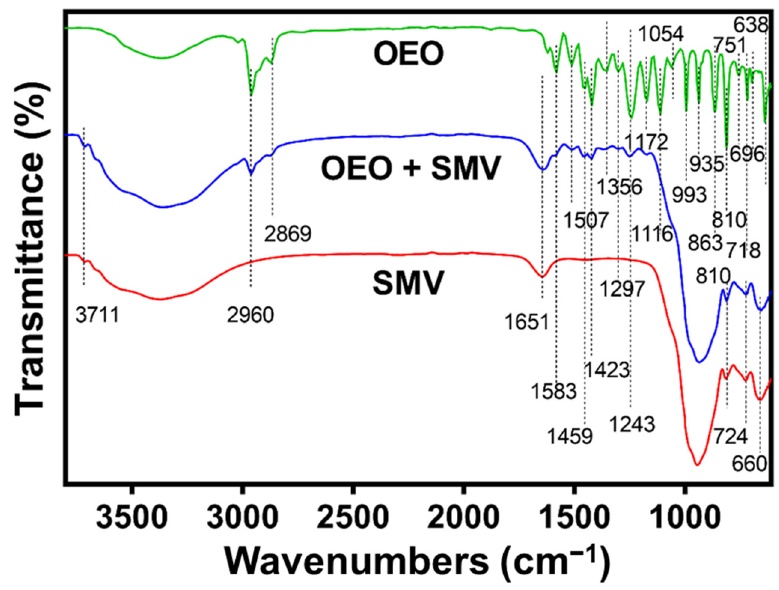
Figure 4. FTIR spectra of OEO, OEO-loaded SMV and SMV.